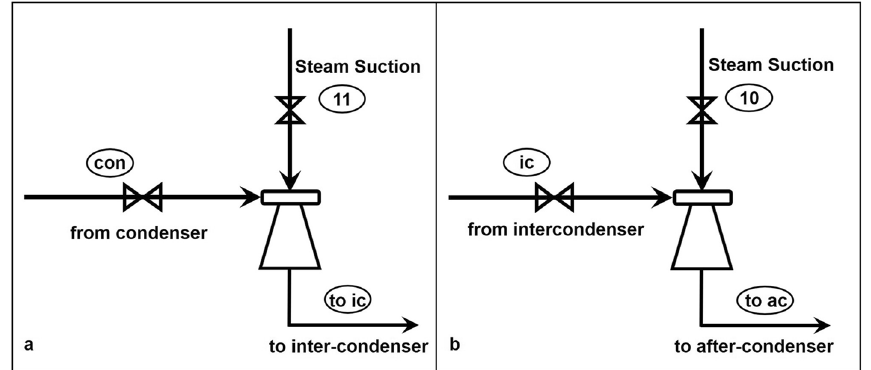
Fig. 8 Stage ejector flow diagram. The saturation pressure (P t ) of the hot gas and water vapor pressure (P wv ) in the system at a temperature of 25 0 C is indicated by pressure at state 11 (P 11 ) as the first-stage ejector ( a ) and pressure at state 10 (P 10 ) as the second stage ejector ( b